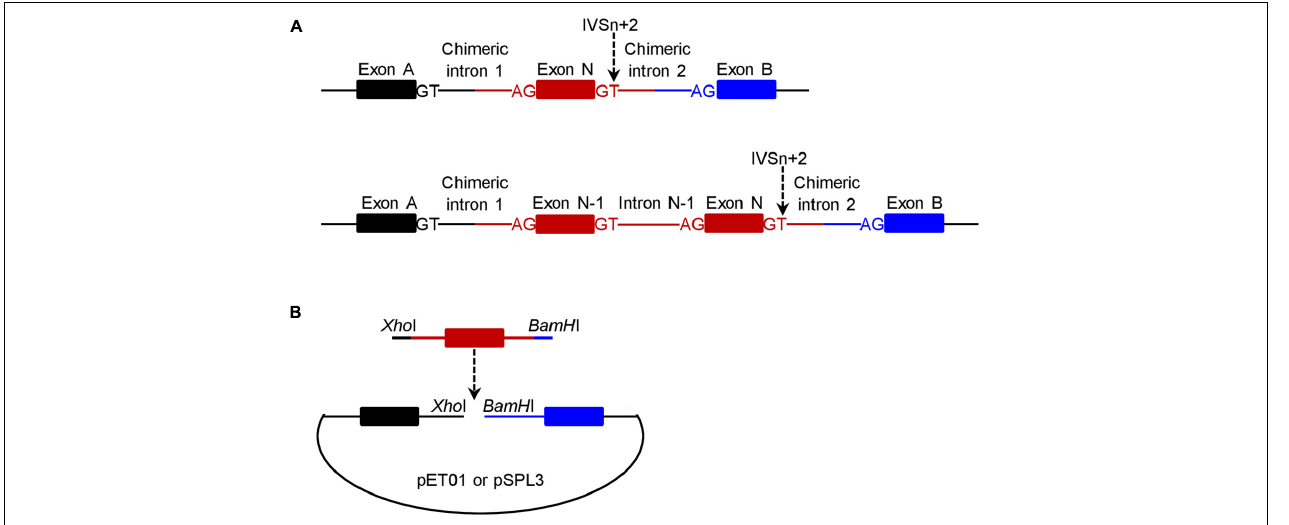
FIGURE 1 | Schematic illustrations of the minigene expression constructs in the context of wild-type inserts. (A) Illustration of the target gene sequence (in red) inserted into the pET01 and pSPL3 exon trapping vectors. The number of the +2T > C variant-affected intron is N and the IVSn+2T site is indicated by a downward pointing arrow. For most variants ( n = 18), the insert comprised a single exon (i.e., exon N) plus flanking intronic sequences on both sides (upper panel). For two variants, the insert comprised two exons (exon N-1 and exon N) plus flanking and intervening intronic sequences (lower panel). The two exons (exon A and exon B) located within the vector and the canonical splice donor GT and acceptor AG sites defining the two chimeric introns (upper panel) or the two chimeric introns and intron N-1 (lower panel) are also denoted in the figure. (B) Illustration of how a wild-type minigene expression vector was constructed. The insert (in red) was PCR amplified with 5 (cid:48) Xho I-harboring and 3 (cid:48) BamH I-harboring in-fusion primers with respect to the pET01 or pSPL3 vector. The resulting PCR products were inserted into their respective linearized vectors by means of in-fusion